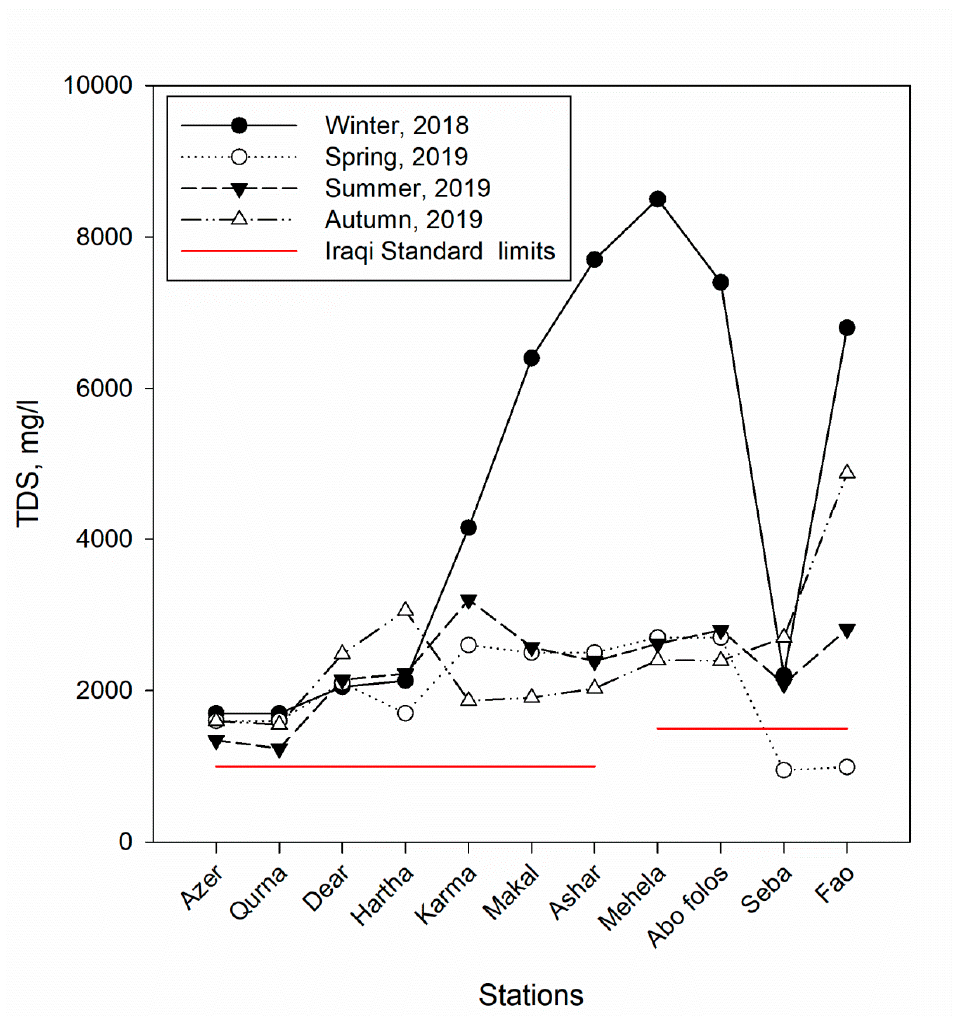
Figure 3. TDS concentrations of the selected stations for different seasons during the study period. The results showed a gradual increase in the values of TDS concentrations from winter 2014 to attain its lowest value in winter 2017. Then, the values of the TDS concentrations rise again to attain its highest value in winter 2018. It is noticed through the spatial distribution of the values of the concentrations of dissolved solids during the comparative study period for the winter season, that they were rising gradually during the years from 2014 to 2016, while fluctuations in the values appear between high and low in the years 2017 to 2019, to record the lowest reading of 320 mg / L during 2017 and the highest reading of 25,304 mg / L in 2018 at the Karma and Fao stations, respectively. In general, relatively low concentrations from 2017 to 2019 indicated high levels of water provided by the Euphrates and Tigris rivers. Various conclusions have been proposed by Hussein et al. [62] and Hammadi [63]. The concentrations of the dissolved solids increased gradually towards the mouth of the river, which coincides with the increase in salinity. This is consistent with the results obtained by AL-Lami [64]. It was also noticed, through the spatial distribution of the concentrations of TDS during the comparative study period for the autumn season that they were significantly high during 2018 compared to the results of the year